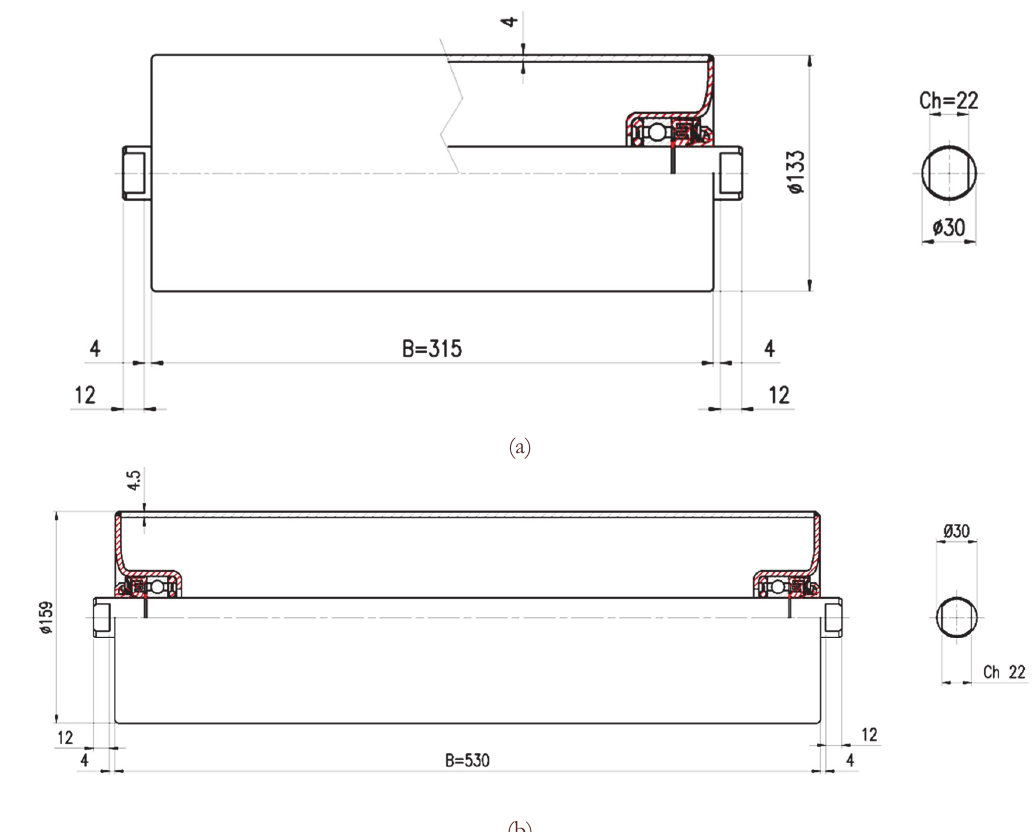
Figure 2: Geometry of the rollers: PSV4 133 315 (a) PSV4 159 530